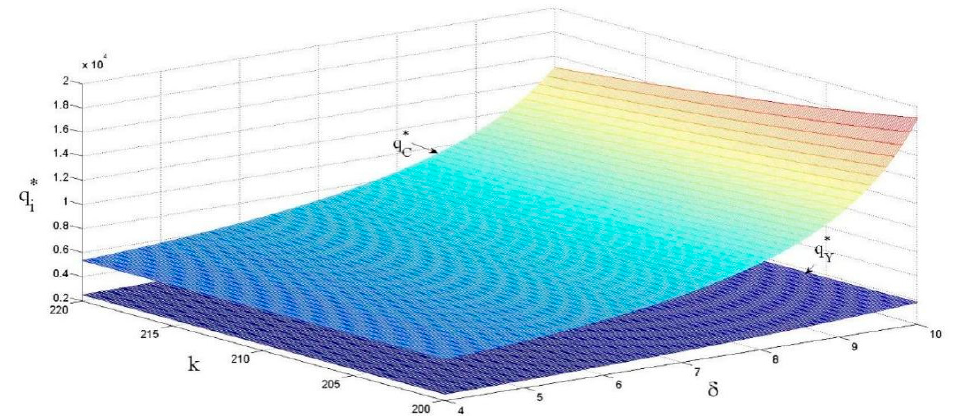
Figure 6. The effects of k and δ on the product sales volume. δ on the product sales volume . Figure 6 . The effects of k and